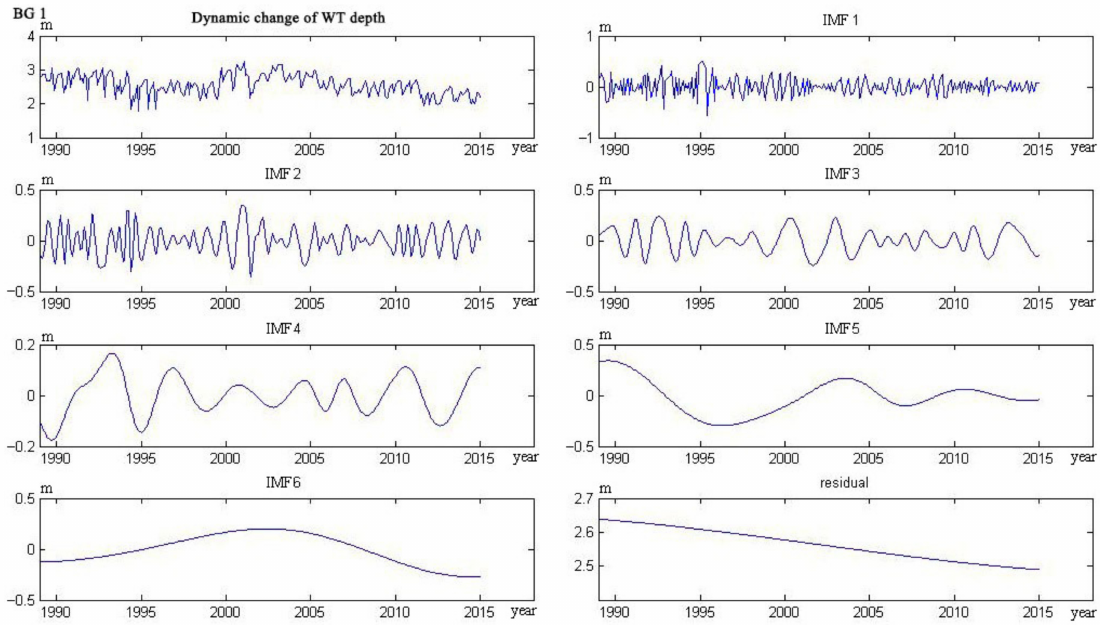
Figure 6. Decomposition of groundwater time series data of well BG1 based on the Empirical Modal Decomposition